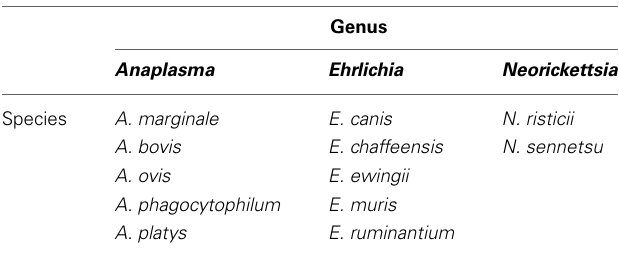
Table 1 | Classification of genus Anaplasma , Ehrlichia, and Neorickettsia in the family Anaplasmataceae (modified after Dumler et al.,